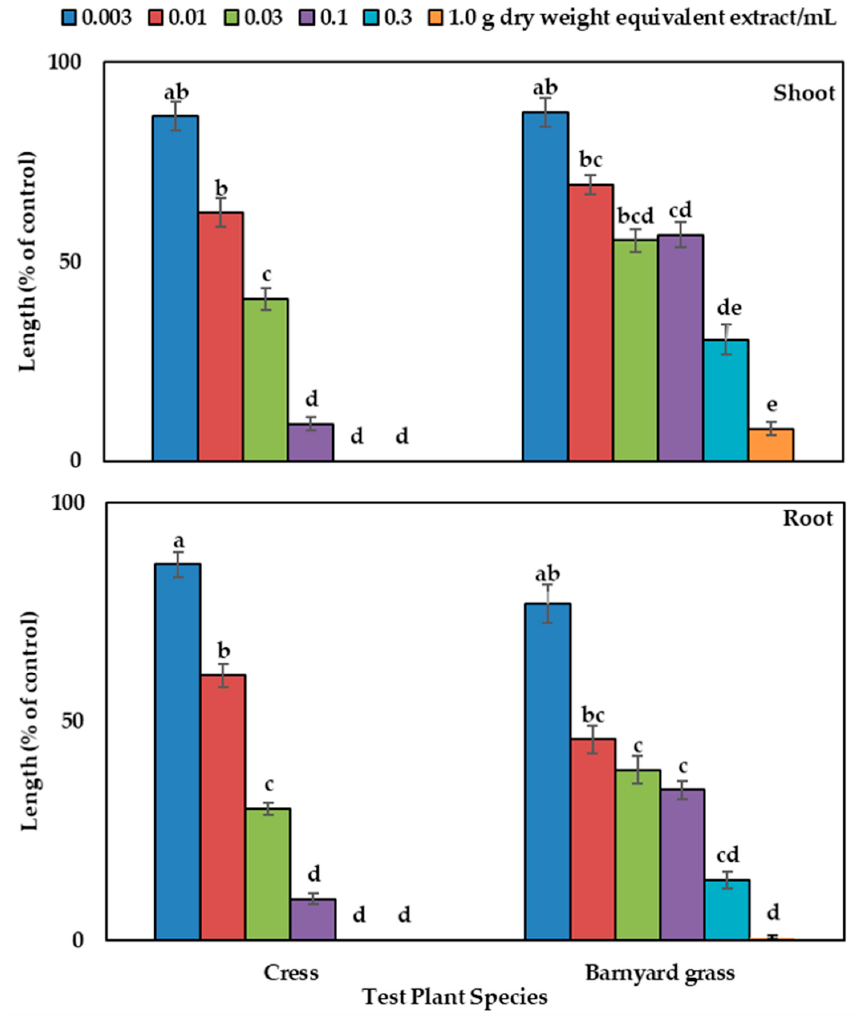
Figure 1. Phytotoxic effects of Albizia richardiana aqueous methanol extracts on shoot and root growth of the cress and barnyard grass. The test plant species were treated at the following concentrations: 0.003, 0.01, 0.03, 0.1, 0.3, and 1.0 g dry weight (DW) equivalent extract of Albizia richardiana /mL. The mean ± standard error from the two independent experiments with three replications for every treatment are displayed (seedling number per treatment = 10, n = 60). The vertical bar denotes standard error of the mean. Various letters denote the significant differences according to Tukey’s HSD test at a 0.05 probability level. Table 1. Concentrations needed for the 50% inhibition of growth (I 50 values) of the tested plants by the Albizia richardiana aqueous methanol